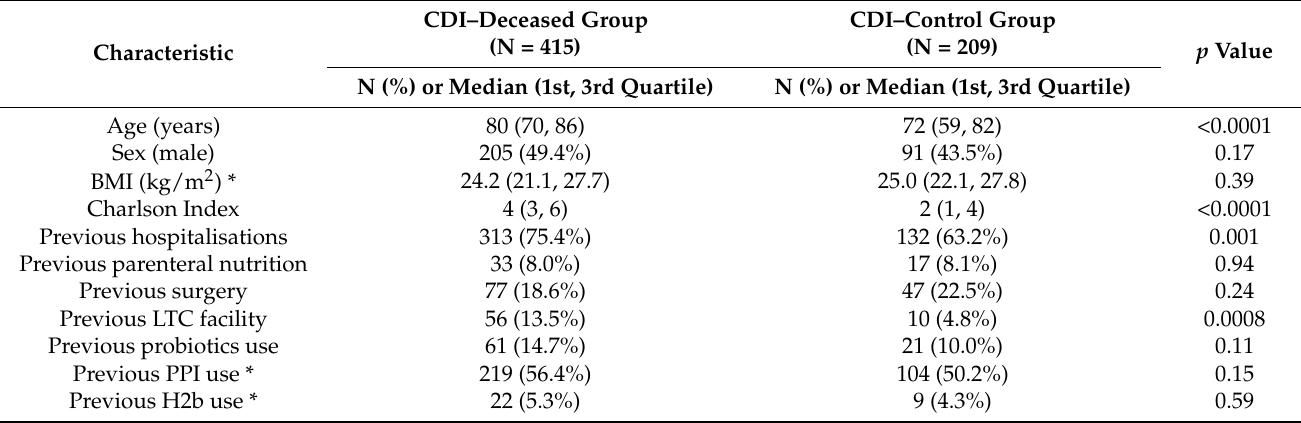
Table 1. Comparison of demographic and clinical data in the study groups.